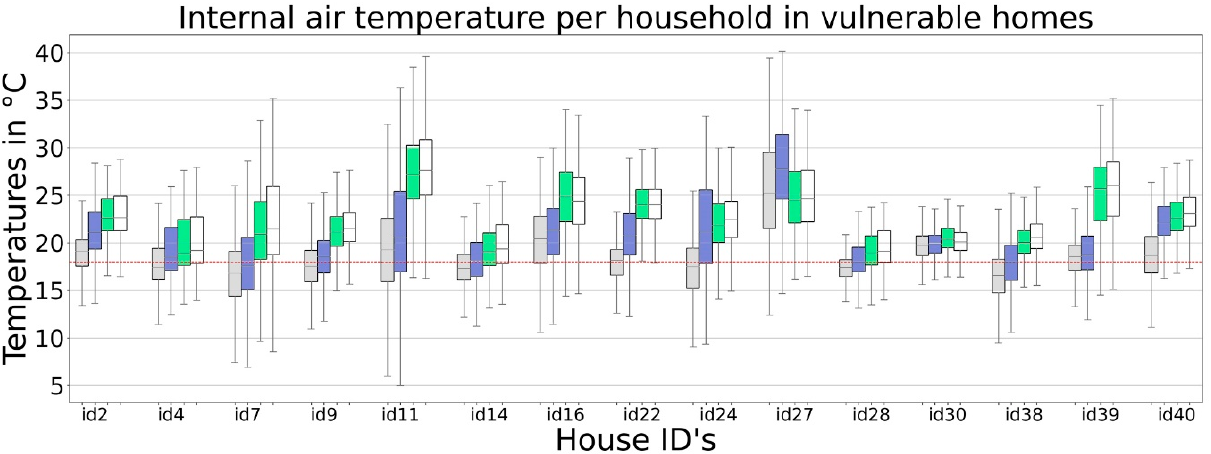
Figure 11. Boxplots of internal temperatures, where the light grey (first from left to right) corresponds to the temperatures monitored with sensors. The blue boxes (second from left to right) correspond to the simulations with double glazing, the green (third from left to right) to the homes only with insulation, and the white (fourth from left to right) correspond to the ones under the NOM-ENER-021 parameters.